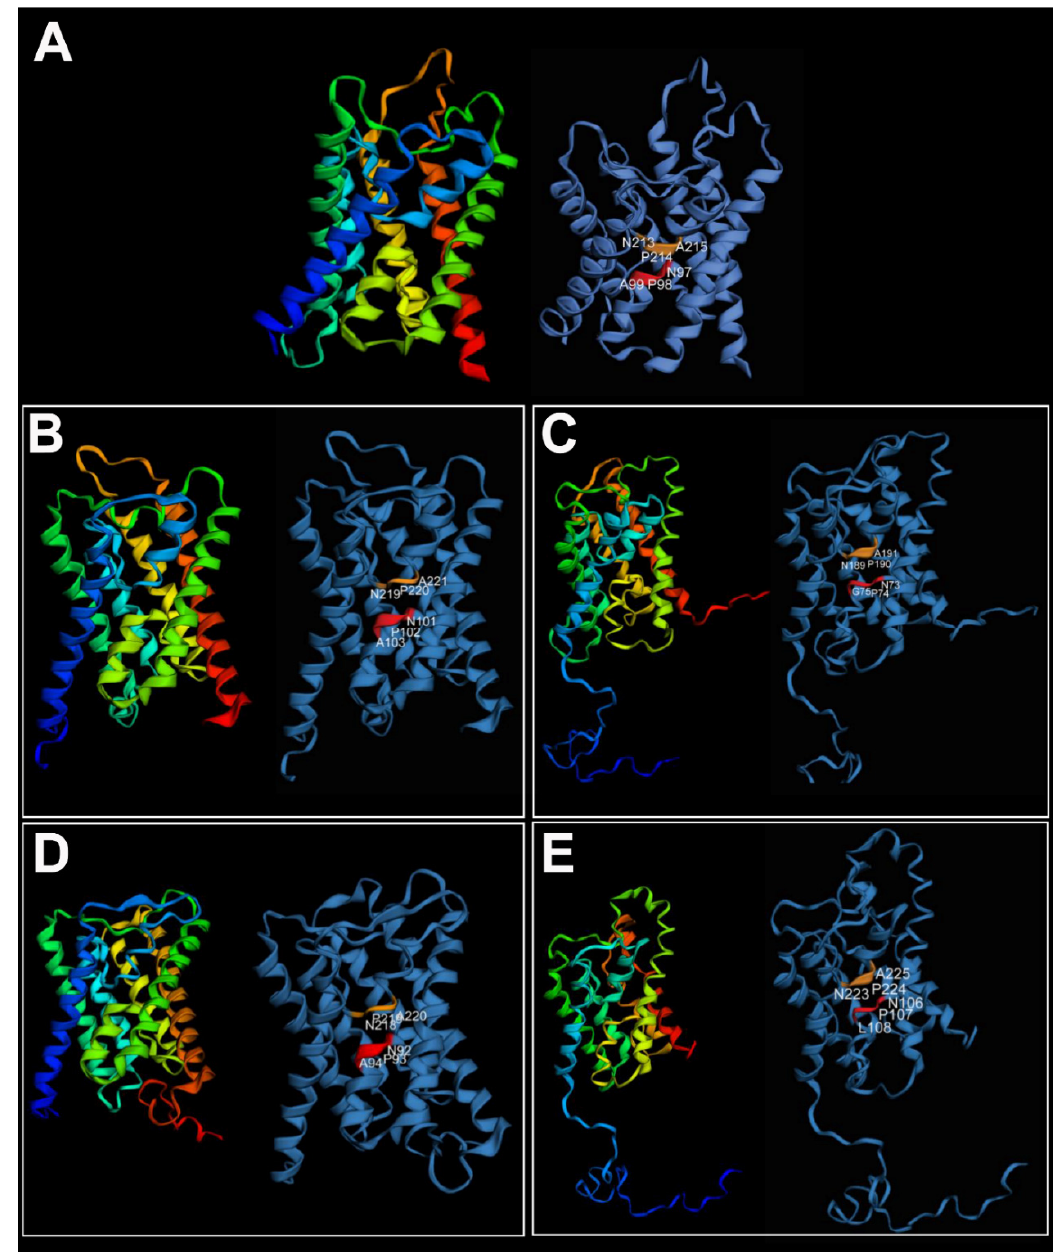
Figure 5. Three-dimensional structure of ( A ) Homo sapiens AQP4 (PDB ID: 3GD8) used as template; ( B ) AsucAQPa ; ( C ) AsucAQPb ; ( D ) AsucAQPc ; ( E ) AsucAQPd . On the left, AQP structures colored in rainbow indicate N to C termini, from blue to red. On the right, NPA motifs are indicated in red and orange. The three-dimensional structure was predicted only for AsucAQPs with complete or almost complete coding sequences.